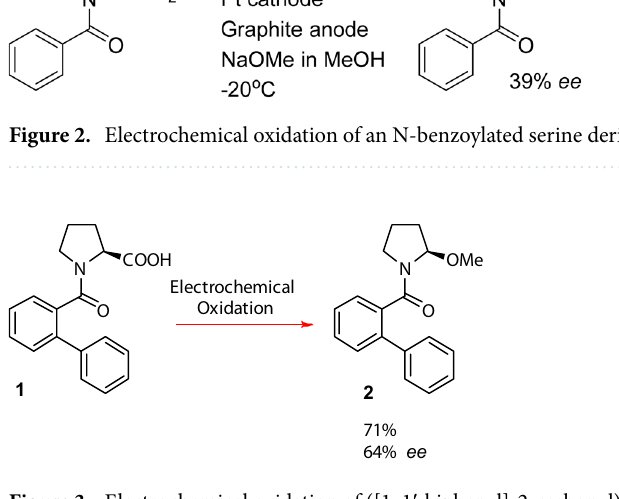
Figure 3. Electrochemical oxidation of ([1, 1 ′ -biphenyl]-2-carbonyl)-l-proline ( 1 ) to proline derivative (R)-[1, 1 ′ -biphenyl]-2-yl (2-methoxypyrrolidin-1-yl) methanone ( 2